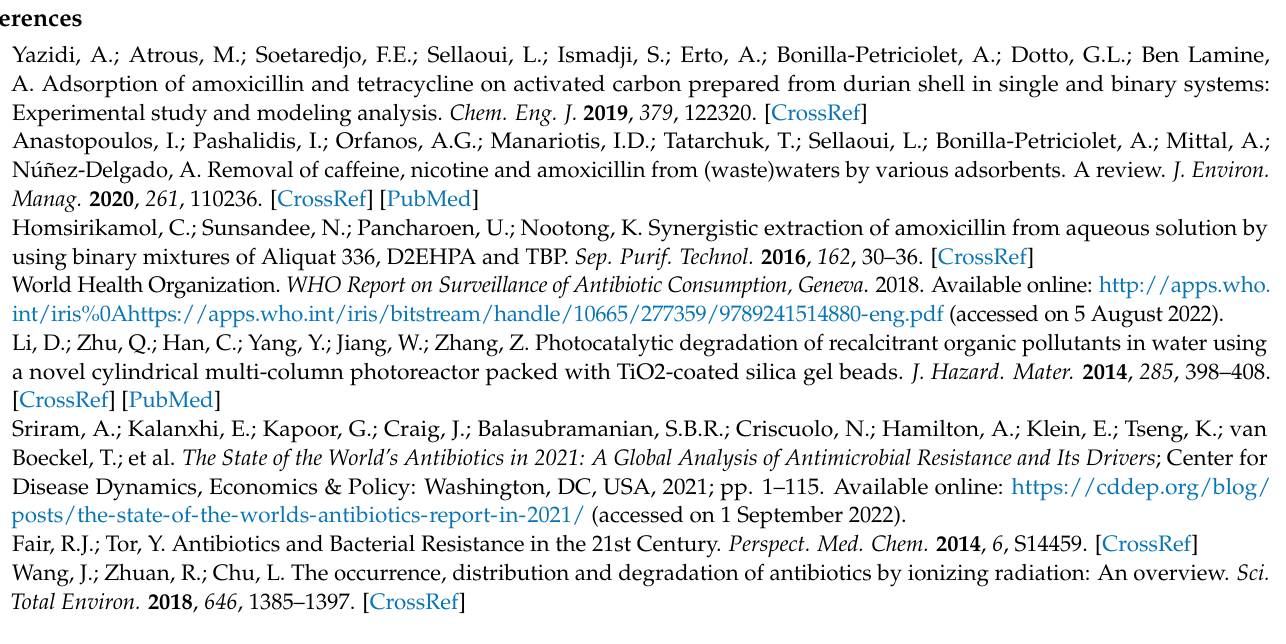
#2, Figure S3: Microspecies #3, Figure S4: Microspecies #4, Figure S5: Microspecies #5, Figure S6: Microspecies #6, Figure S7: Microspecies #7, Figure S8: Microspecies